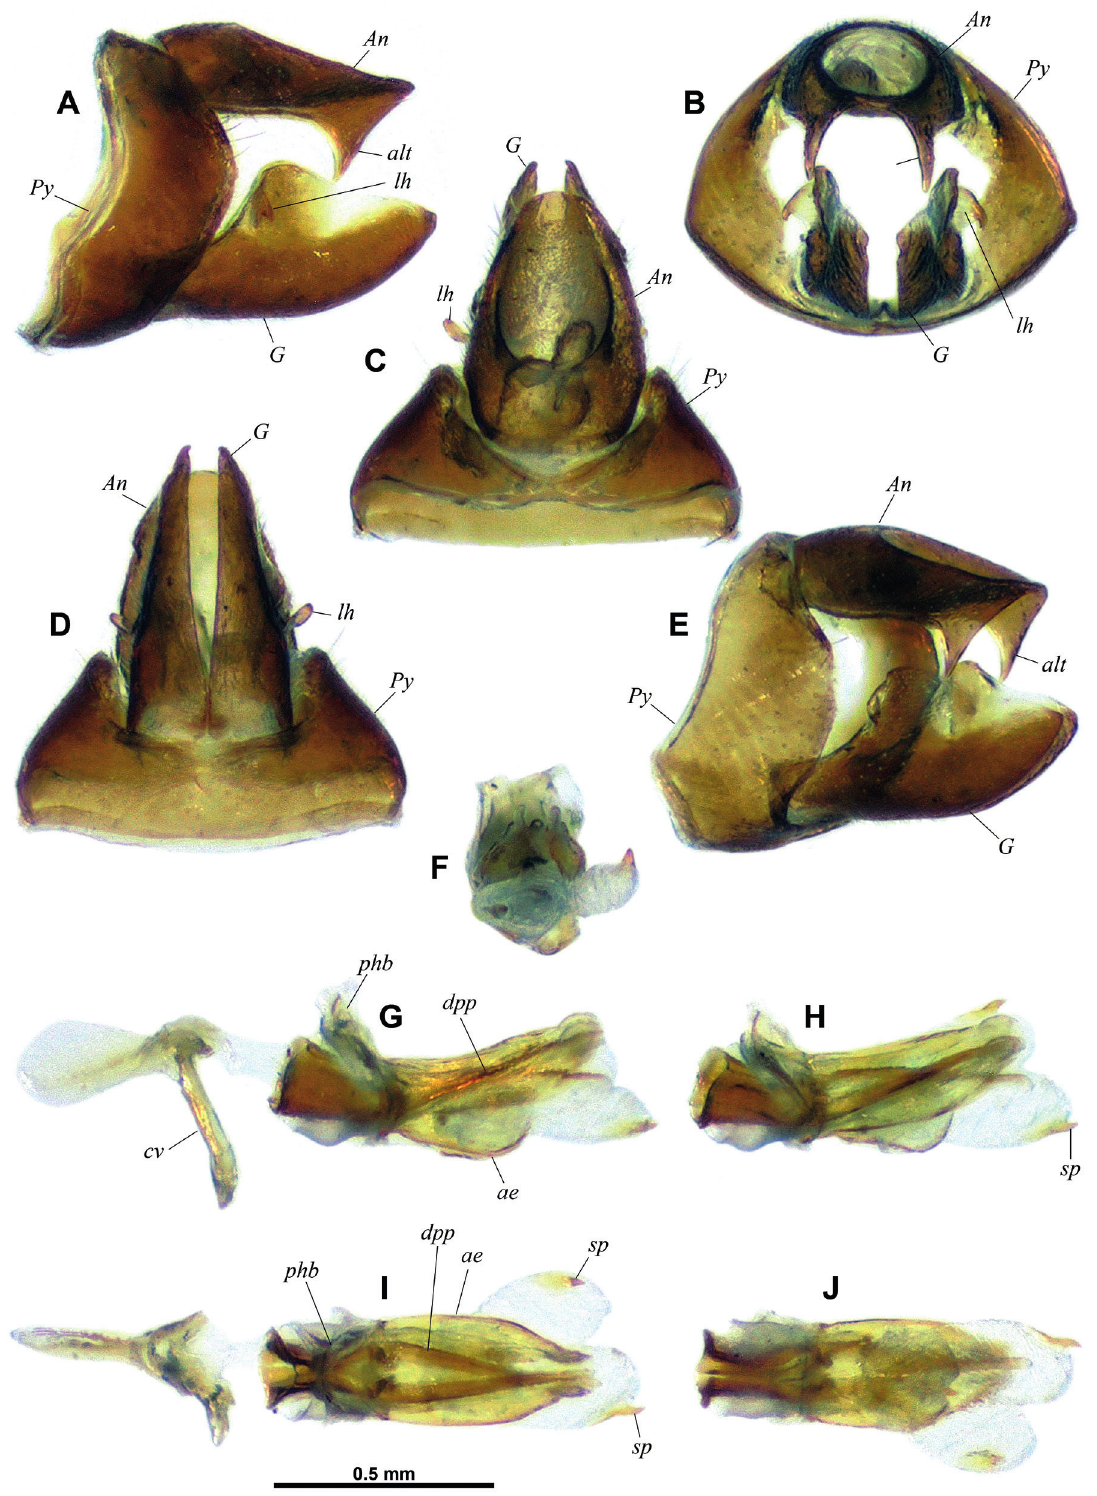
Fig. 14. Cleotyche ( Cleotyche ) montana sp. nov., ♂, holotype (QM). A–E . Pygofer, anal tube and gonostyli. A . Left lateral view. B . Caudal view. C . Dorsal view. D . Ventral view. E . Laterocaudal view. F–J . Aedeagus. F . Caudal view. G . Left lateral view. H . Dorsolateral view. I . Dorsal view. J . Ventral view. Abbreviations: see Fig.